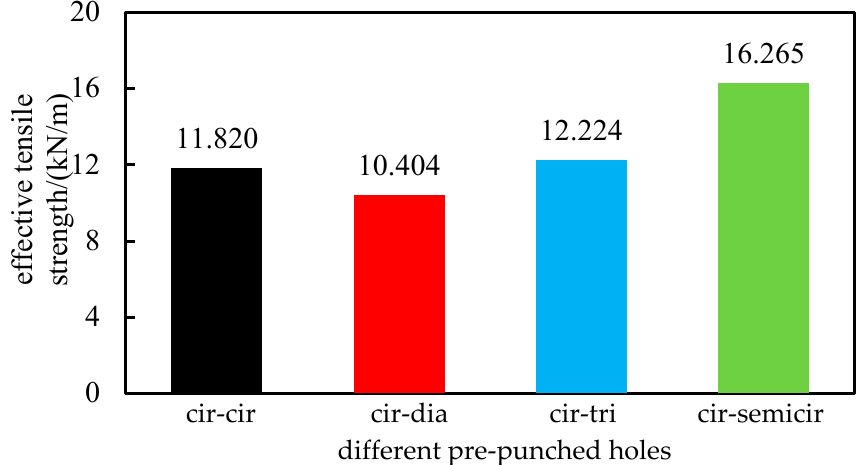
Figure 11. Average of effective tensile strength of performance-optimized multi-axial geogrid with different pre-punched holes.